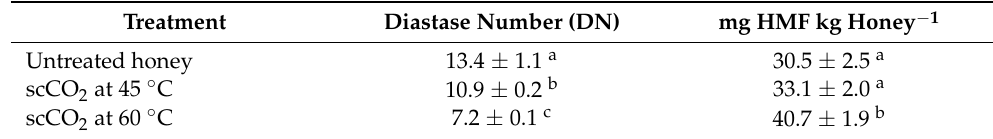
Table 1. Hydroxymethylfurfural and diastase content in untreated honey and honey subjected to the scCO 2 treatment at 10 MPa and 60 min at increasing